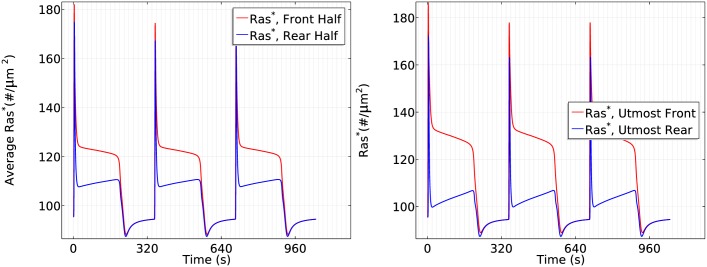
Cell responses to consecutive waves.Left: The time course of the front and rear halves when three waves pass the WT cell at v = 5μm/s. Right: The time course of Ras* activity at the antipodal points.